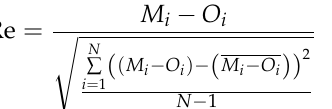
Figure 2. Training dataset comparison. Least-square line equation and the square of the linear correlation coefficient are also shown for ( a ) Hoke D6 design and ( b ) composite factorial design. Both axes represent b in Ws 1/2 m −2 K.